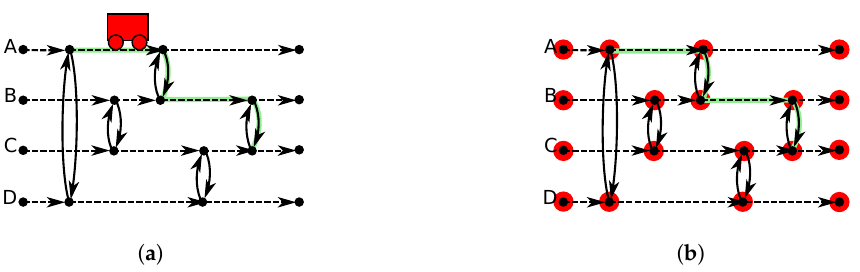
Figure 2. Models for routing over a graph using Q-learning. The learning agents are marked in red. Navigation problem. ( a ) The agent is the message, actions and states are graph nodes; ( b ) Routing Problem. Each node is an agent, the actions are next-hop nodes.